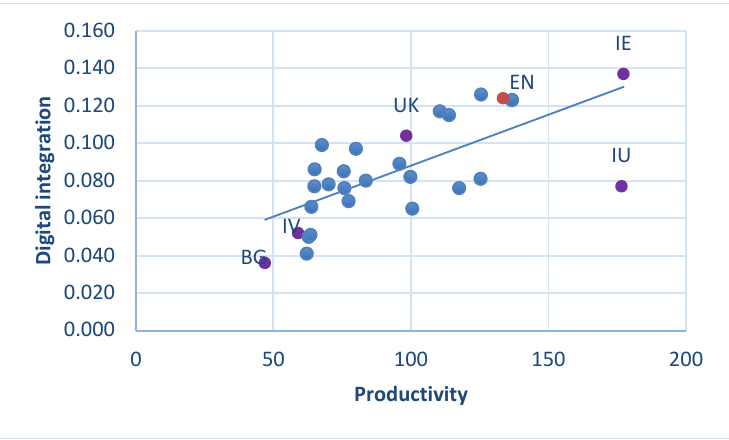
Figure 1. The relationship between digital integration and productivity. Source: Processing based on data provided by Eurostat [16].